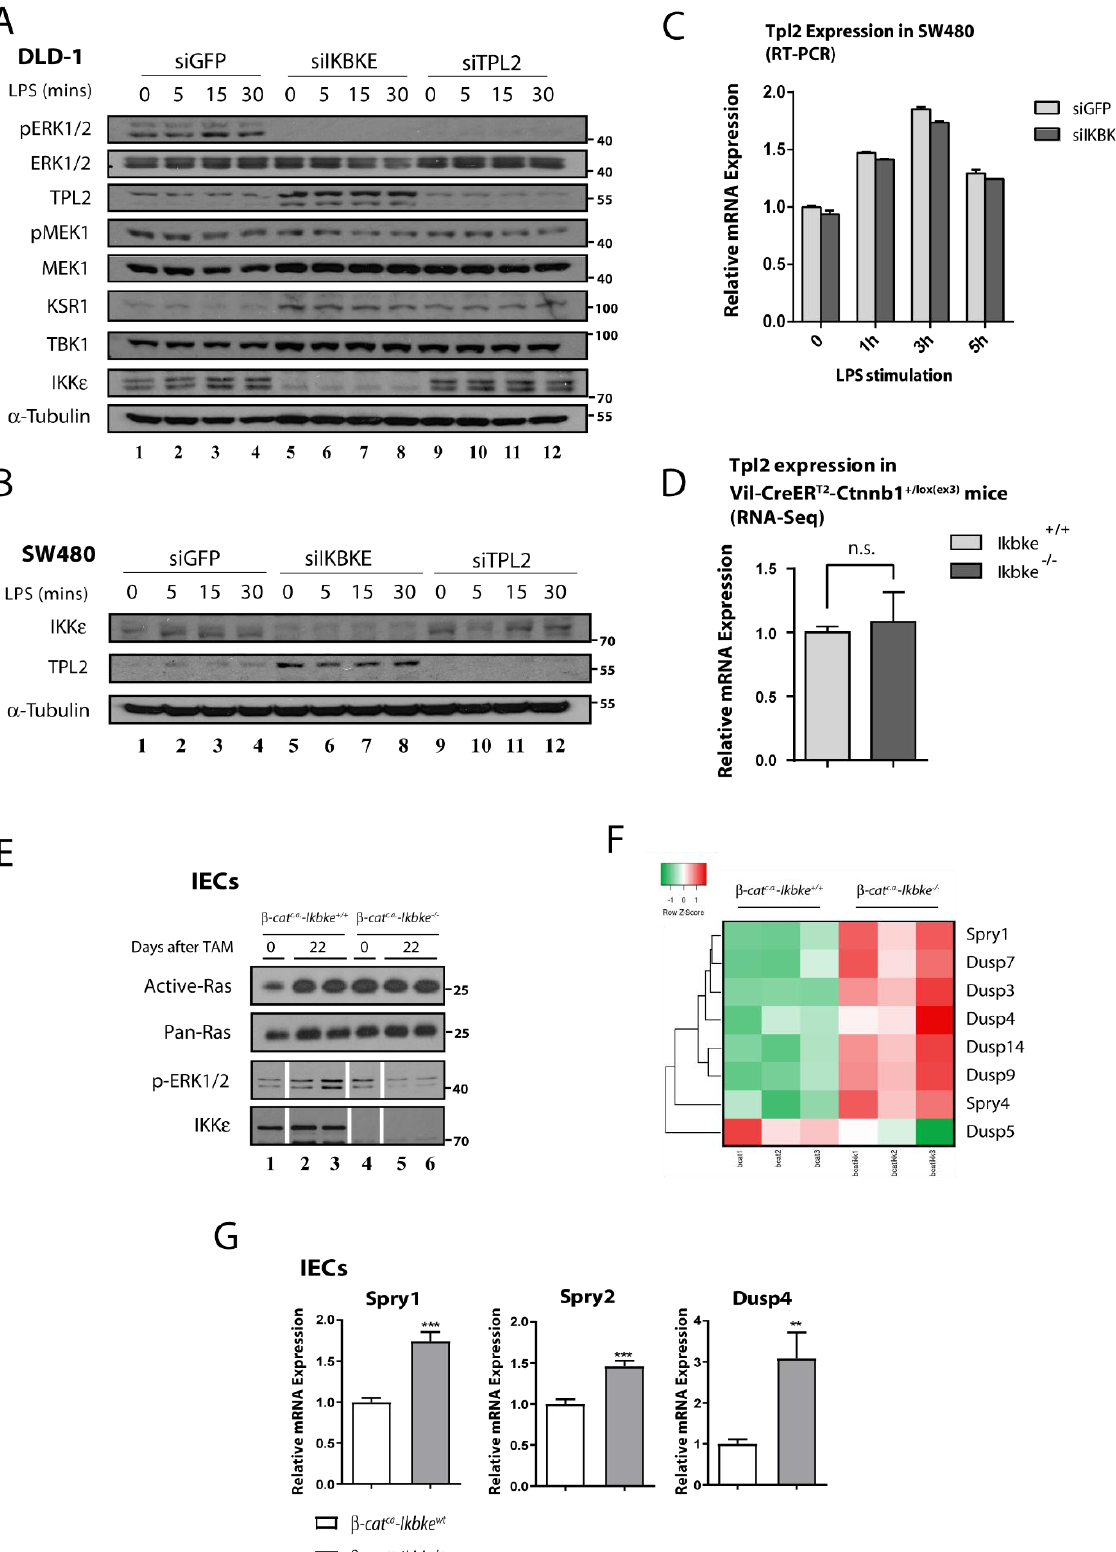
Figure 2: TPL2 protein levels are stabilized in CRC cell lines upon IKBKE loss. MEK1 and ERK1/2 phosphorylations are affected from loss of IKKɛ or TPL2 by siRNA knockdown in DLD-1 cells, as meas- ured by WB using the indicated antibodies. Additionally, TPL2 protein stabilization upon loss of IKKɛ both in DLD-1 (A) and (B) SW480 cells (DLD-1 cells were stimulated 0-5 hours; SW480 cells